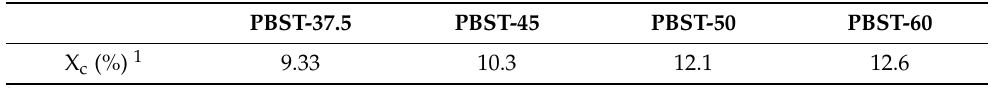
Table 3. Crystallinity of PBT in PBST copolymers with different BT